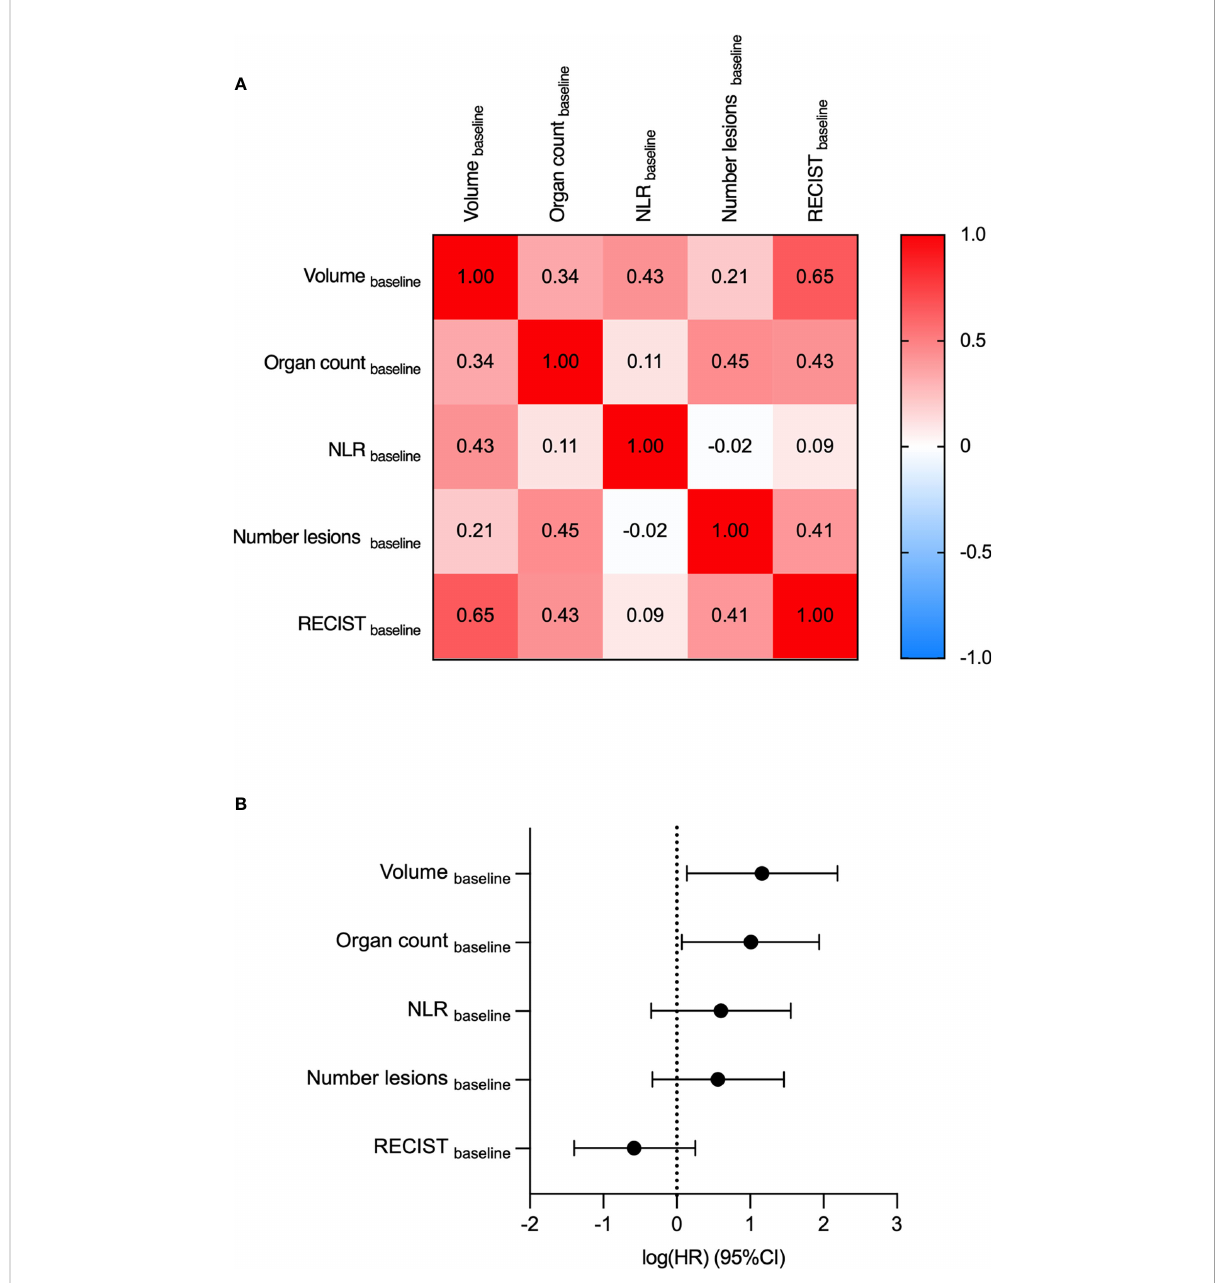
FIGURE 3 Multivariate analyses determine Volume baseline and Organ count baseline as the most predictive variables for OS. Volume baseline , Organ count baseline , NLR baseline , Number of lesions baseline and RECIST baseline were compared by multivariate analyses. (A) The Spearman correlation coef fi cients of the fi ve parameters. (B) Log-hazard ratio (HR) according to each covariate. Data are shown as HR (95%